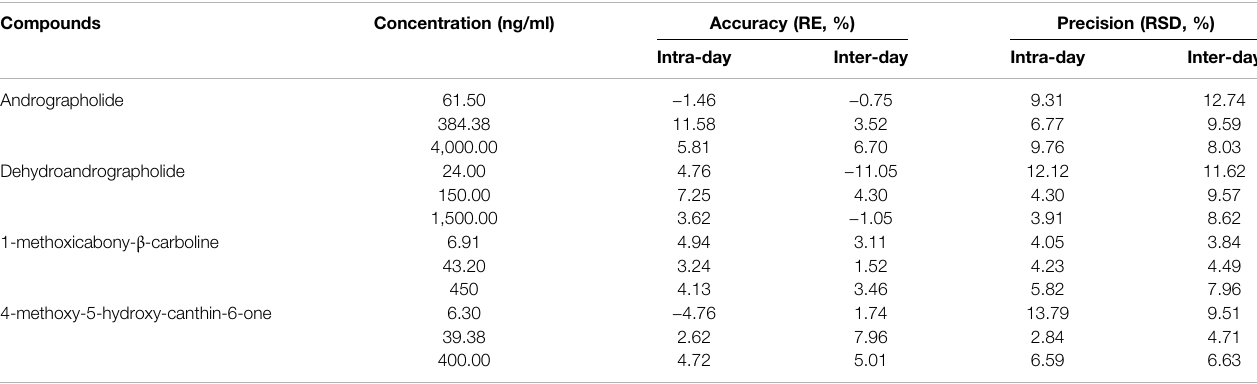
TABLE 3 | |Precision and accuracy of four compounds in rat serum ( n = 6). Compounds